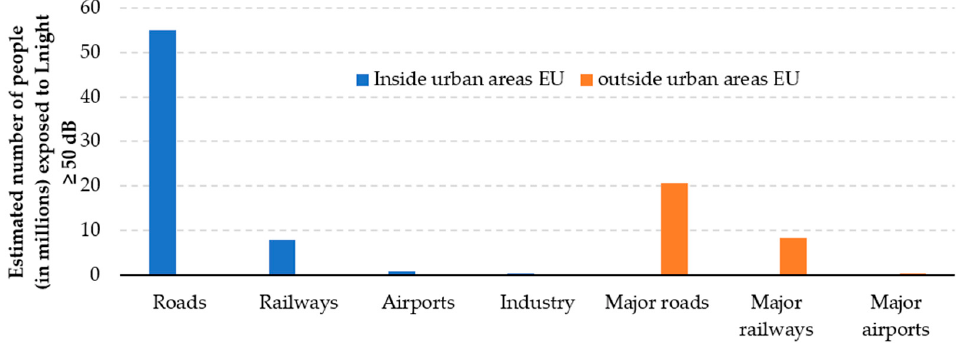
Figure 7. Number of people exposed to night-time noise (Lnight) ≥ 50 db in Europe, 2019 [13].